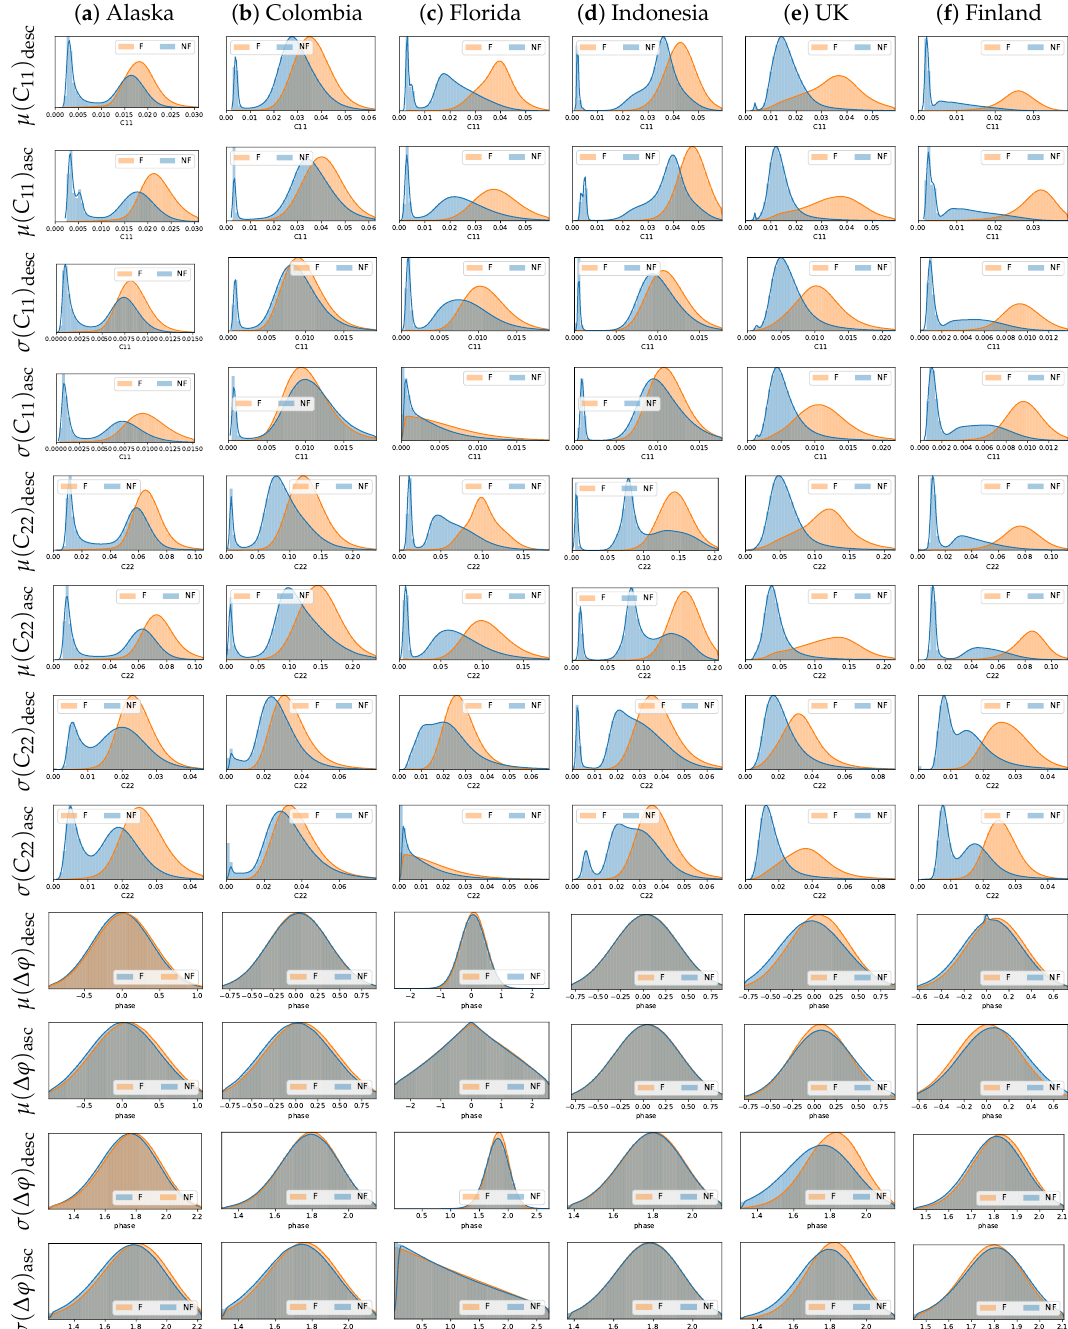
Figure 4. This figure shows the distribution of the annual mean and standard deviation of VV and VH backscatter as well as the phase difference per land cover class (forest, non-forest) according to the reference data. Forest distributions are shown in orange, non-forest in blue. Each row shows either mean or standard deviation for one of the variables, for one orbit direction. The columns represent the distributions for the different study sites.